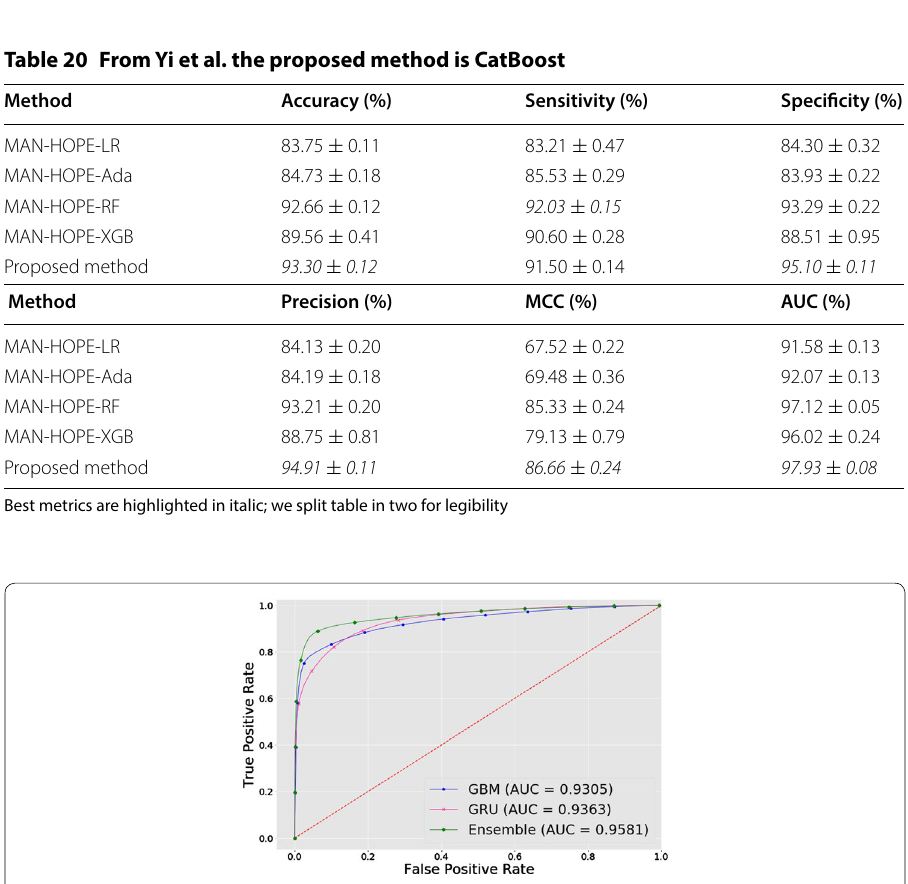
Fig. 8 Image from [39] illustrating best results for ensemble of CatBoost and GRU ; Here, the authors refer to CatBoost as Gradient Boosted Machine